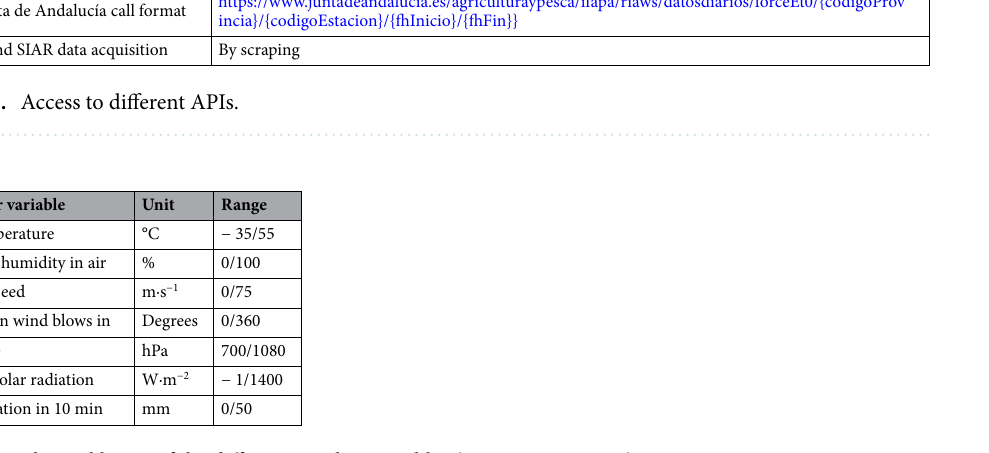
Table 2. Physical limits of the different weather variables (UNE